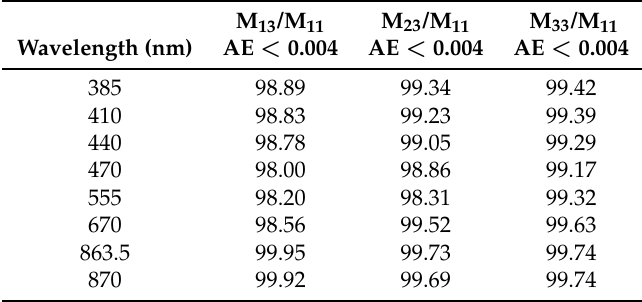
Table 4. Percentage of cases for elements M 13 /M 11 , M 23 /M 11 , and M 33 /M 11 with Absolute error (AE) of elements less than